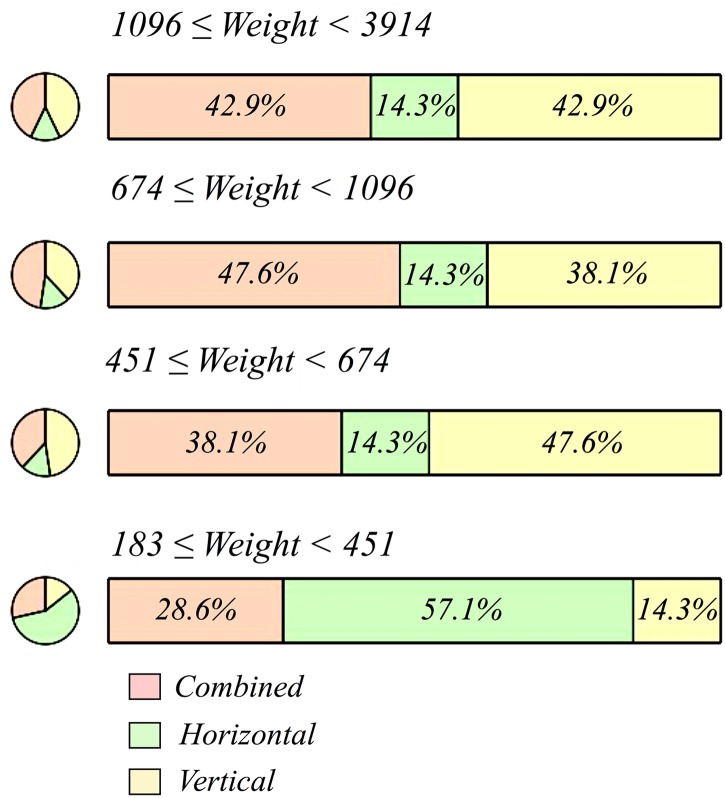
Tool functioning direction (TFD) and weight.Bar plot of TFD grouped by quartiles of weight (in grams).